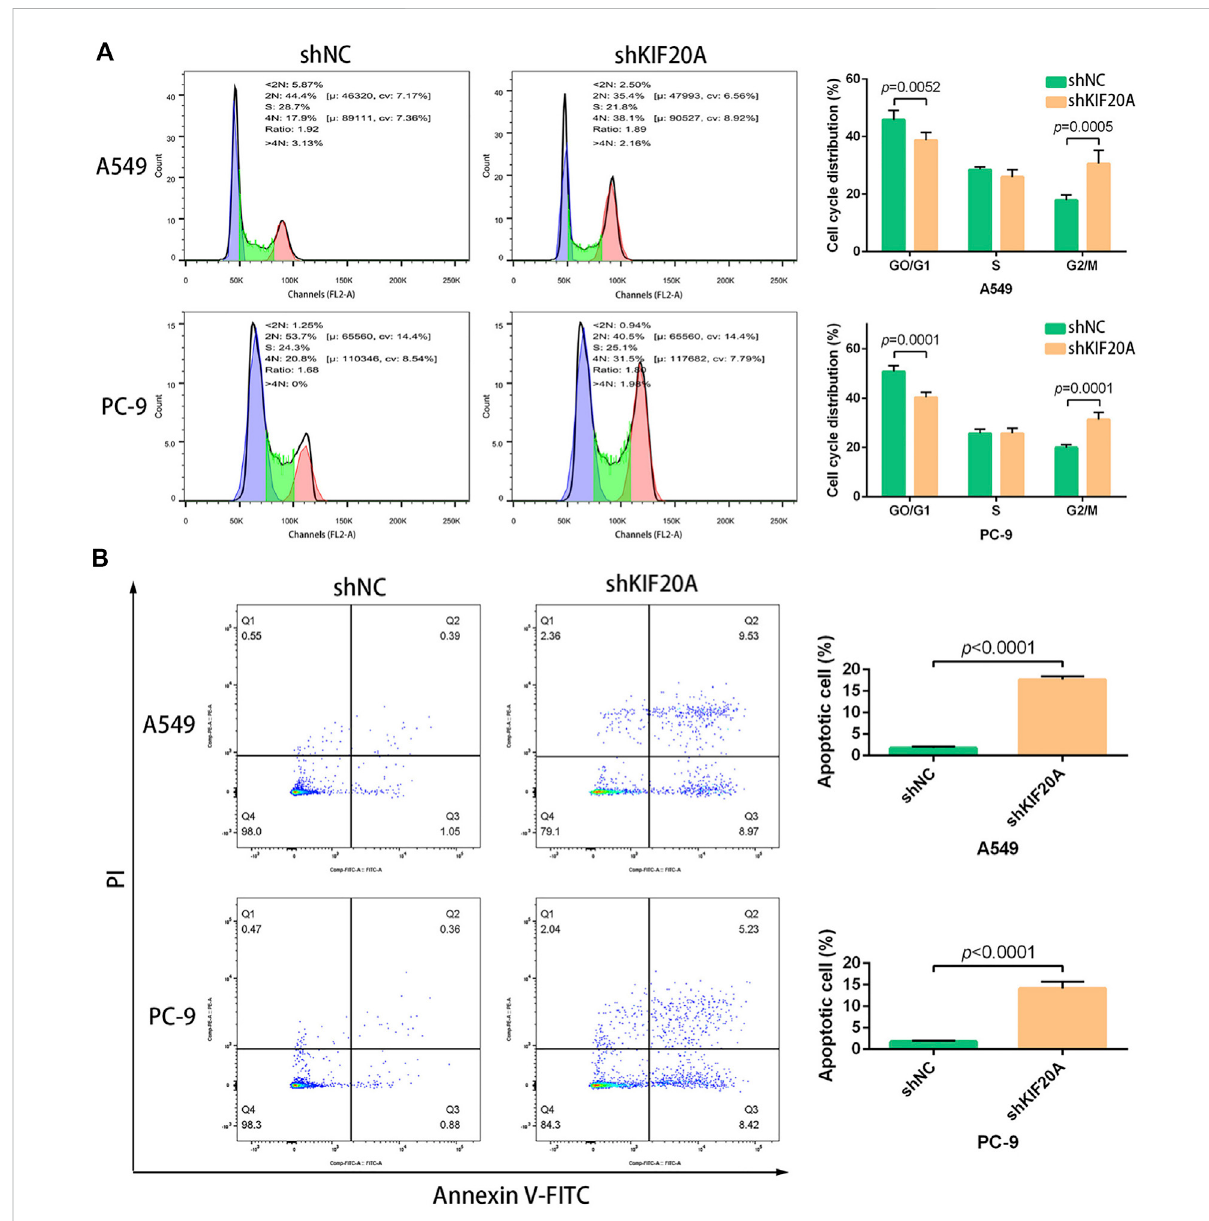
FIGURE 11 Effects of KIF20A knockdown on cell cycle and apoptosis inA549 and PC-9 cells. KIF20A knockdown induced G2/M arrest (A) and promoted apoptosis (B) 48 h after